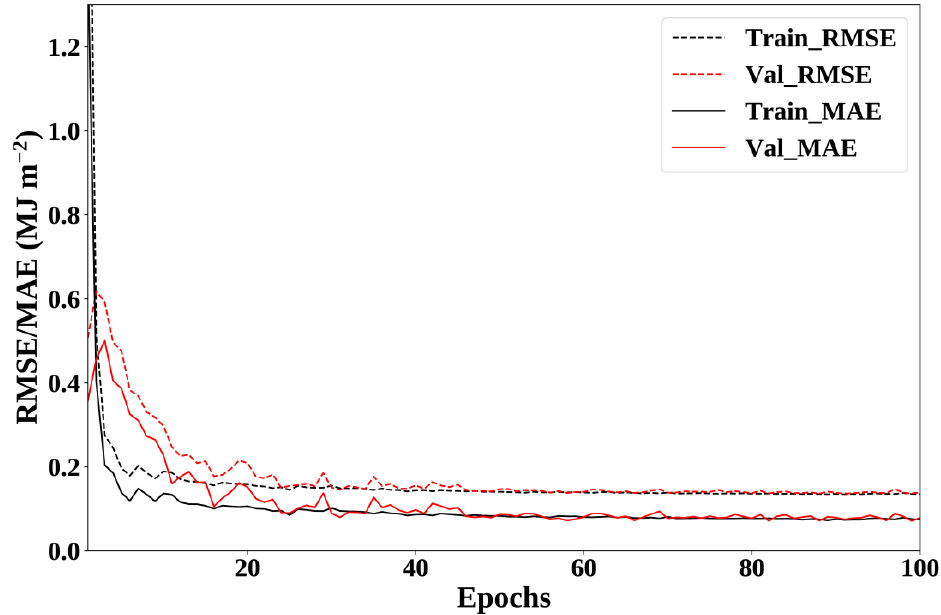
Figure 5. Training history with the change of accuracy as a function of the epochs of the CNN model, where the black and red lines refer to training datasets and validation datasets, respectively; the solid and dotted lines represent the root mean square error (RMSE) and mean absolute error (MAE), respectively.